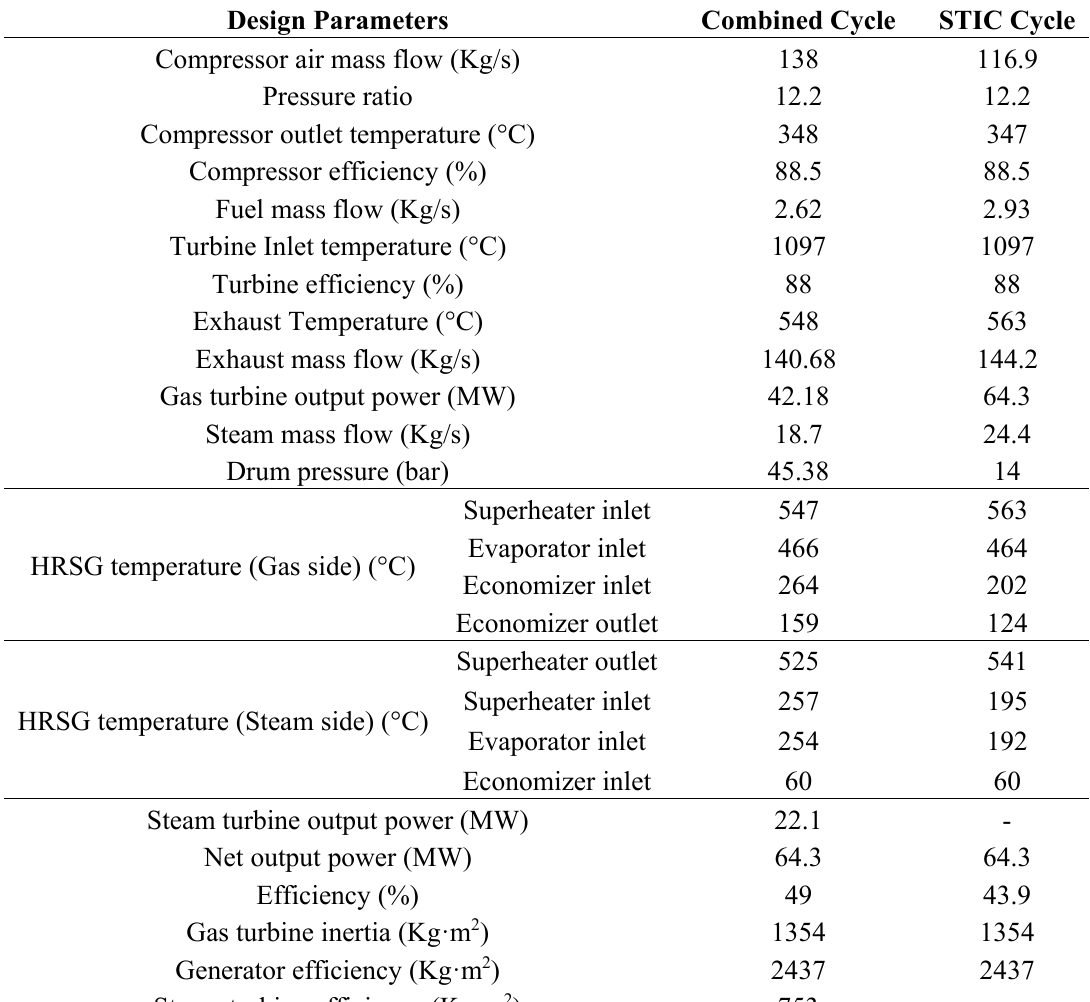
Figure 1. Combined cycle ( a ) and STIG cycle ( b ). Table 1. The sample unit design